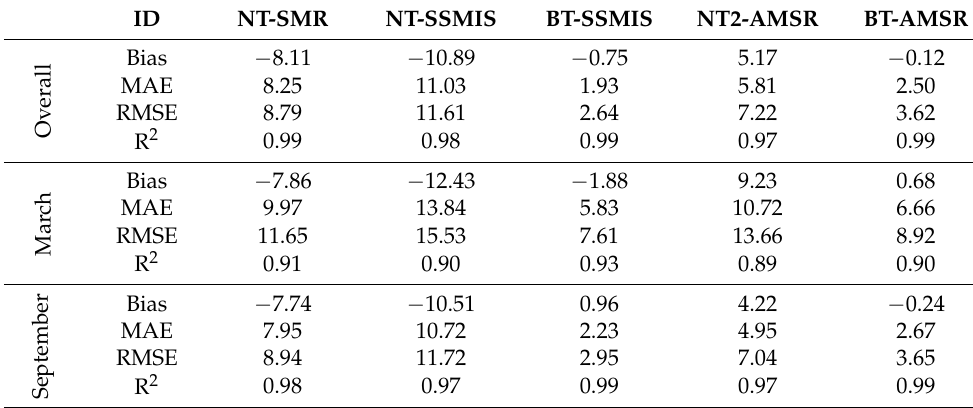
Figure 10. Same as in Figure 8 but in the Antarctic. Table 5. Same as in Table 4 but in the